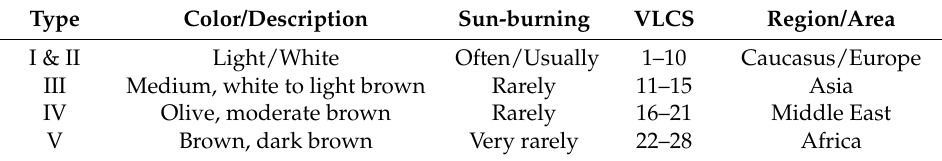
Table 1. Human skin types and associated region [8].